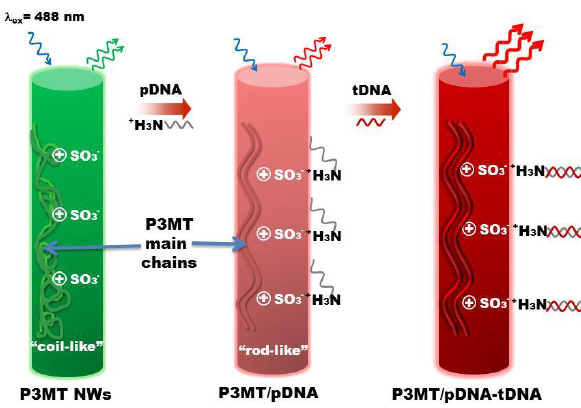
Figure 1. Schematic illustration for optical tDNA recognition using light-emitting P3MT NWs.